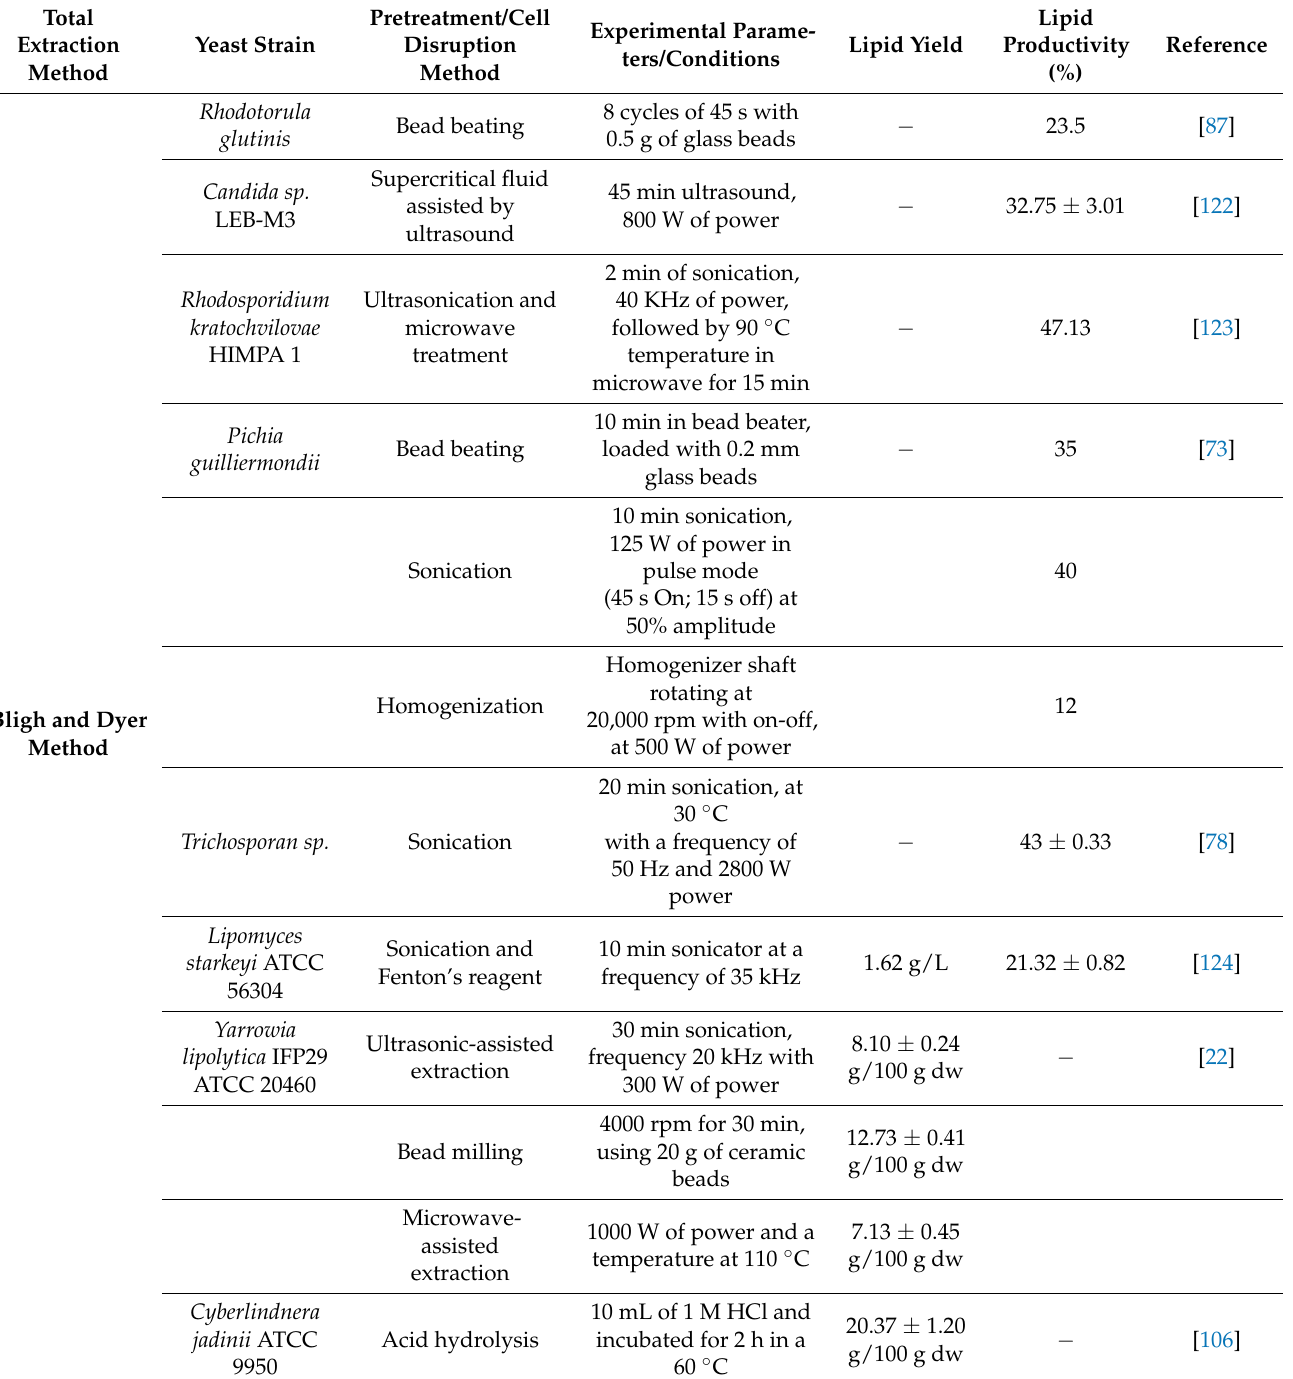
after a pretreatment either using a mechanical or nonmechanical method. Table 4. Applications of the Bligh and Dyer and the Folch methods for the recovery of intracellular lipids from various oleaginous